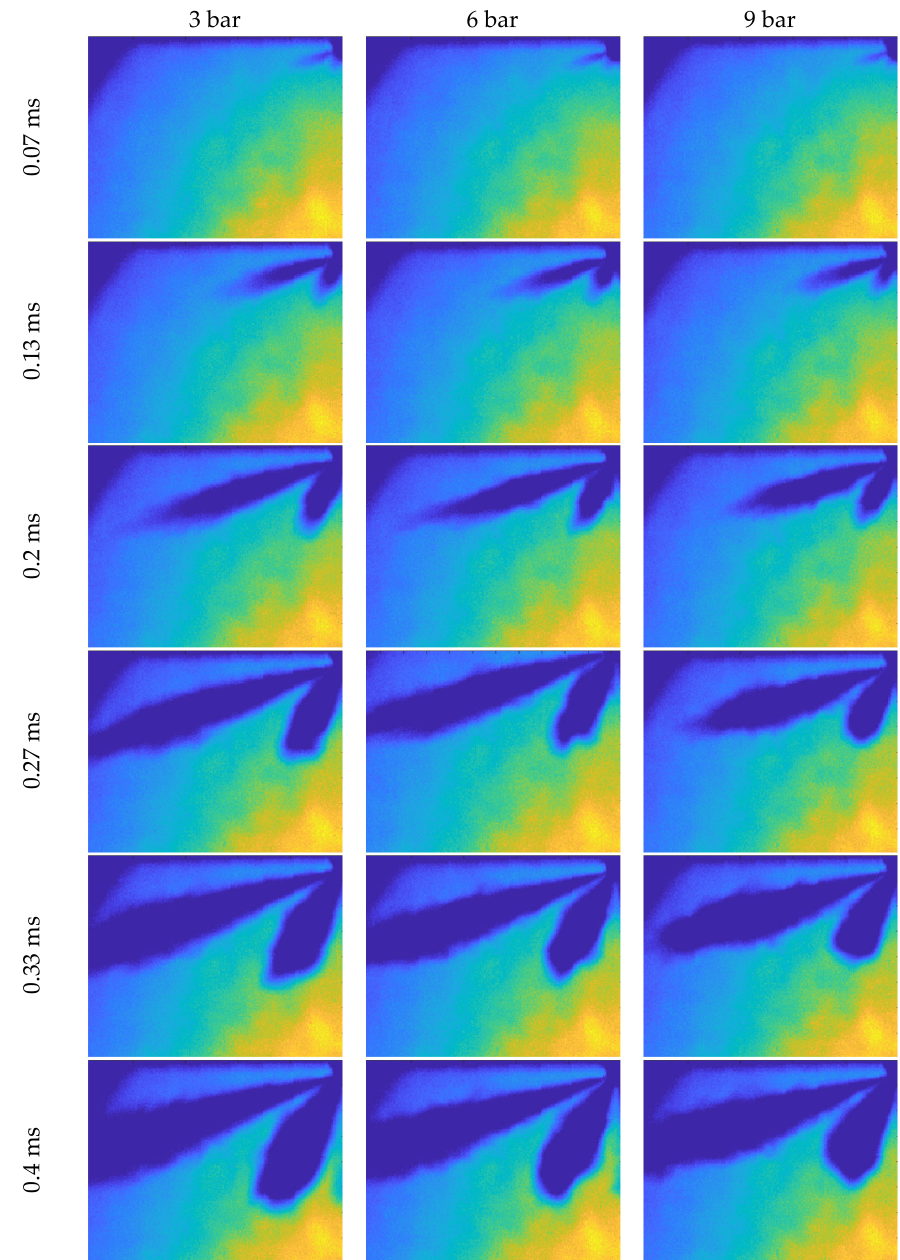
Figure 5. Typical consecutive photos of spray in the vessel at 3, 6 and 9 bar ambient pressure and room temperature. The time interval between the frames is 1/15,000 s. Time starts at the start of the hydraulic injection (aSOI), when the spray exits the nozzle hole.